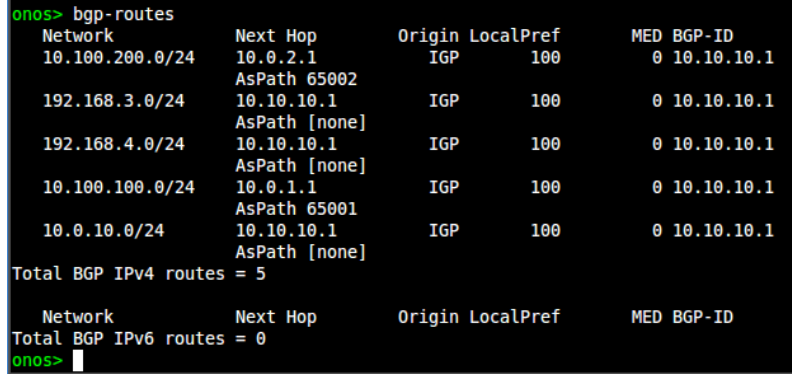
Figure 20. Routes Learnt by ONOS.